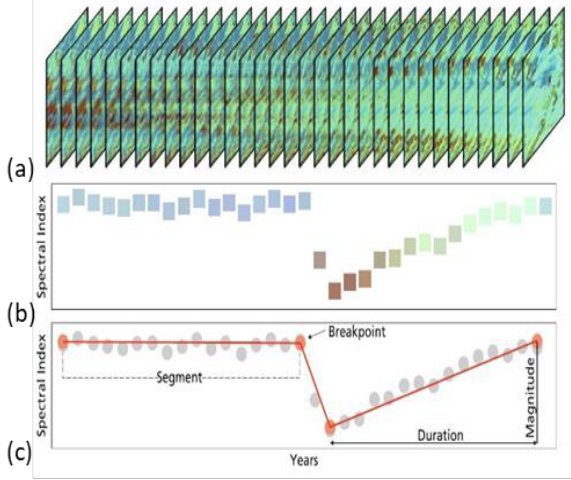
Figure 2. Change detection concept of Landtrendr algorithm.